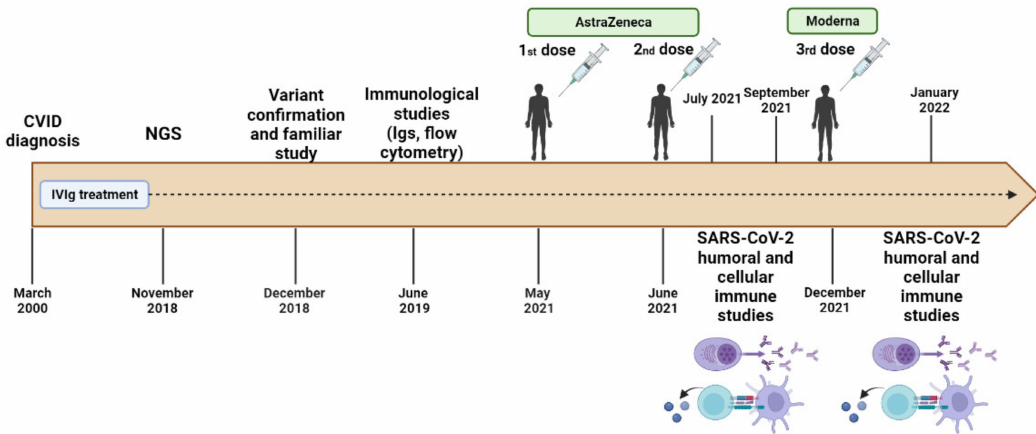
Figure 1. Study design. Timeline of the experimental plan and the schedule of the SARS-CoV-2 vaccine doses. CVID: common variable immunodeficiency; NSG: next-generation sequencing; IVIg: intravenous immunoglobulin treatment; Igs: